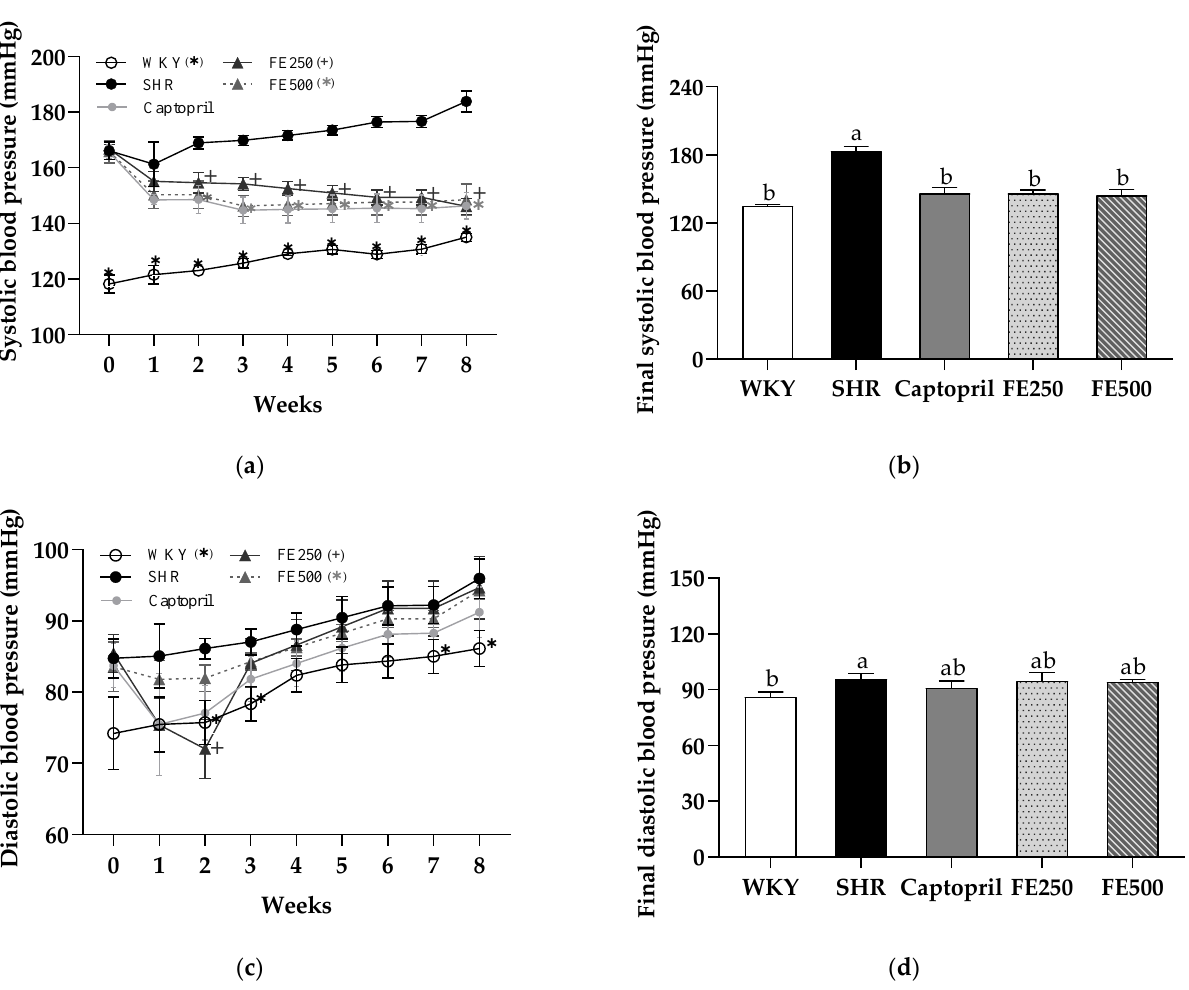
Figure 2. Systolic blood pressure ( a ), final systolic blood pressure ( b ), diastolic blood pressure ( c ) and final diastolic blood pressure ( d ) in the SHRs during 8 weeks of oral administration. WKY, Wistar Kyoto rats; SHR, Spontaneously hypertensive rats; Captopril, SHRs treated with 50 mg/kg bw of captopril; FE250, SHRs treated with 250 mg/kg bw of FE; FE500, SHRs treated with 500 mg/kg bw of FE; FE, finger millet ethanol extract. Data are expressed as means ± standard errors of the mean ( n = 6). Different letters above the bars indicate significant differences at p < 0.05.